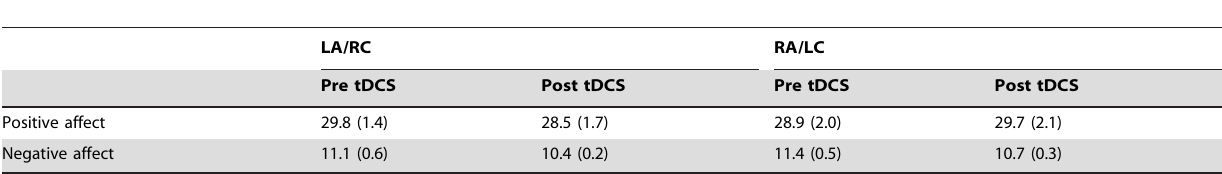
Table 2. Mean scores before (pre) and after (post) tDCS for the PANAS. Standard errors are shown in parentheses.